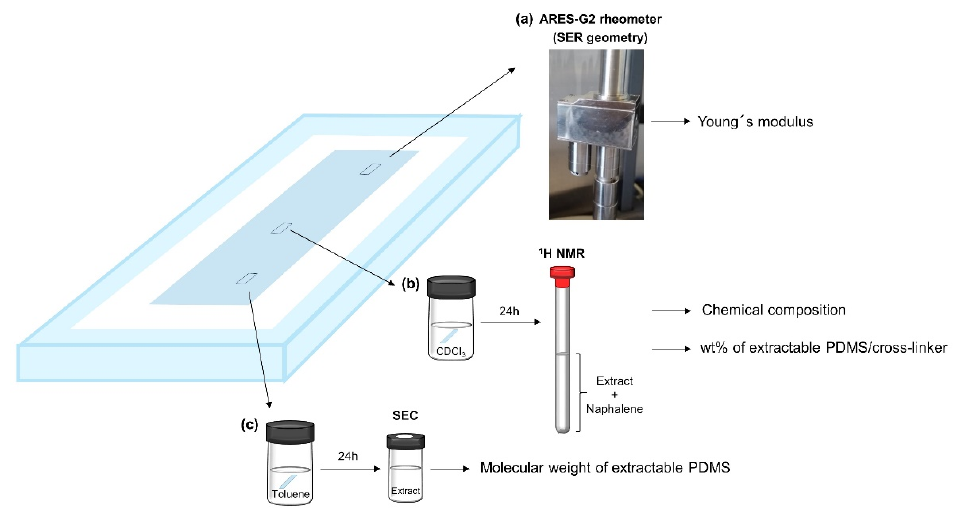
Figure 14. Methods used to evaluate the stability and network structure of elastomer films: ( a ) ARES-G2 rheometer equipped with SER geometry was used to track changes in Young´s modulus over time;( b ) 1 H NMR was used to analyze the chemical composition of the extract and to determine the wt% of extractable PDMS/cross-linker; ( c ) SEC was used to measure the molecular weight of extractable PDMS.